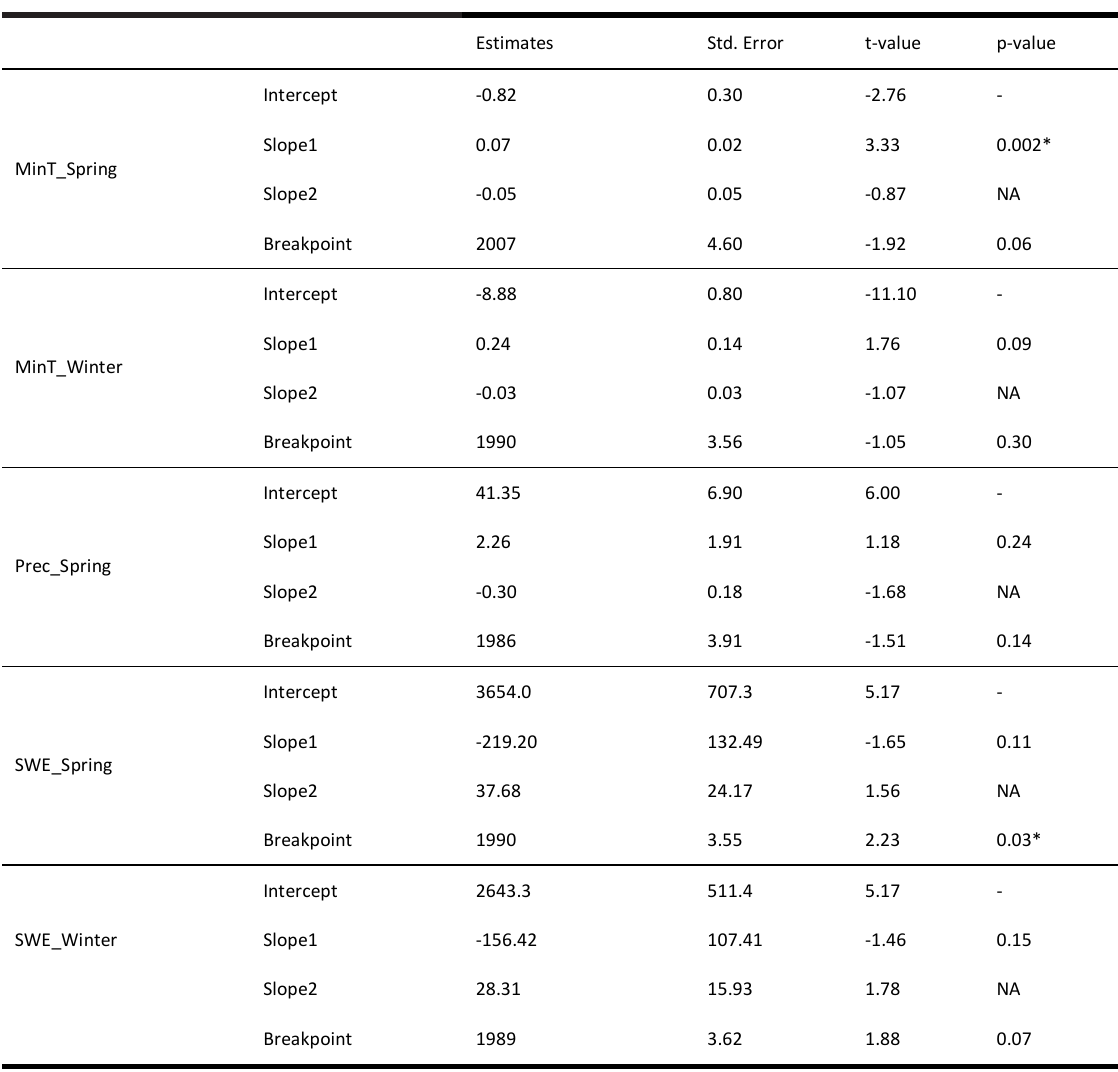
Table S4. Summary of the piecewise regressions on the five focal environmental variables. MinT_Spring is the average minimum daily spring temperature, MinT_Winter is the average minimum daily winter temperature, Prec_Spring is the total precipitation in spring, SWE_Spring is the total spring snow water equivalent and SWE_Winter is the total winter snow water equivalent. We rescaled year to obtain more intuitive intercept estimates (year 1980 = 0). Slope1 refers to the segment before the breakpoint and Slope2 refers to the segment after the breakpoint. We also show the statistics associated with the identified breakpoint. Asterisks next to the p-values show significance at the 0.05 level. The p-value for Slope2 is NA since standard asymptotics do not apply (Muggeo, 2008). No p-values are provided for the intercept because this test is not of biological